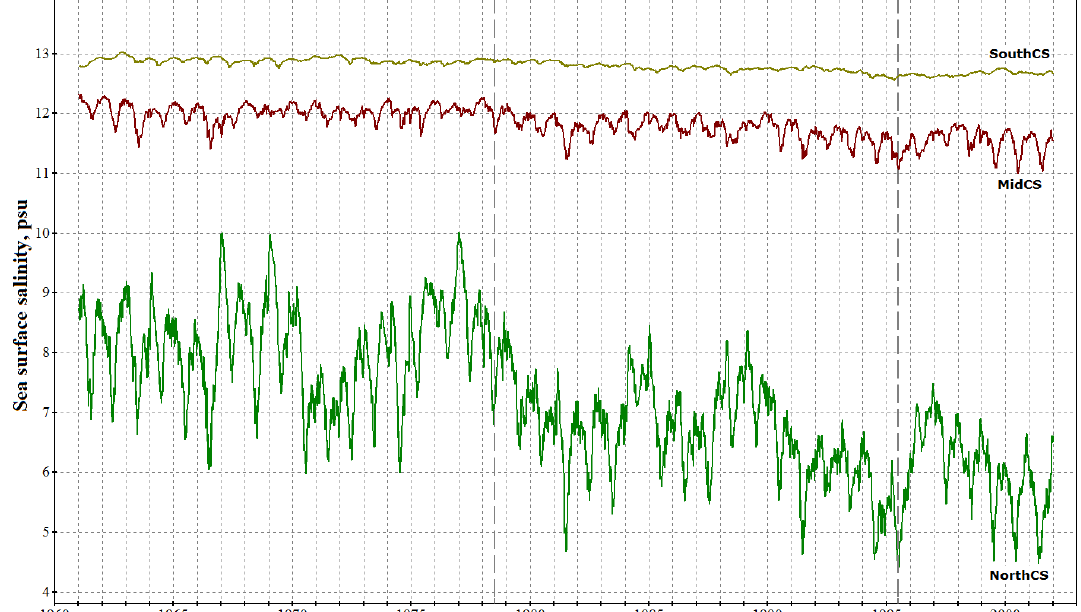
Figure 8. Evolution of sea surface salinity (SSS) averaged over three Caspian basins